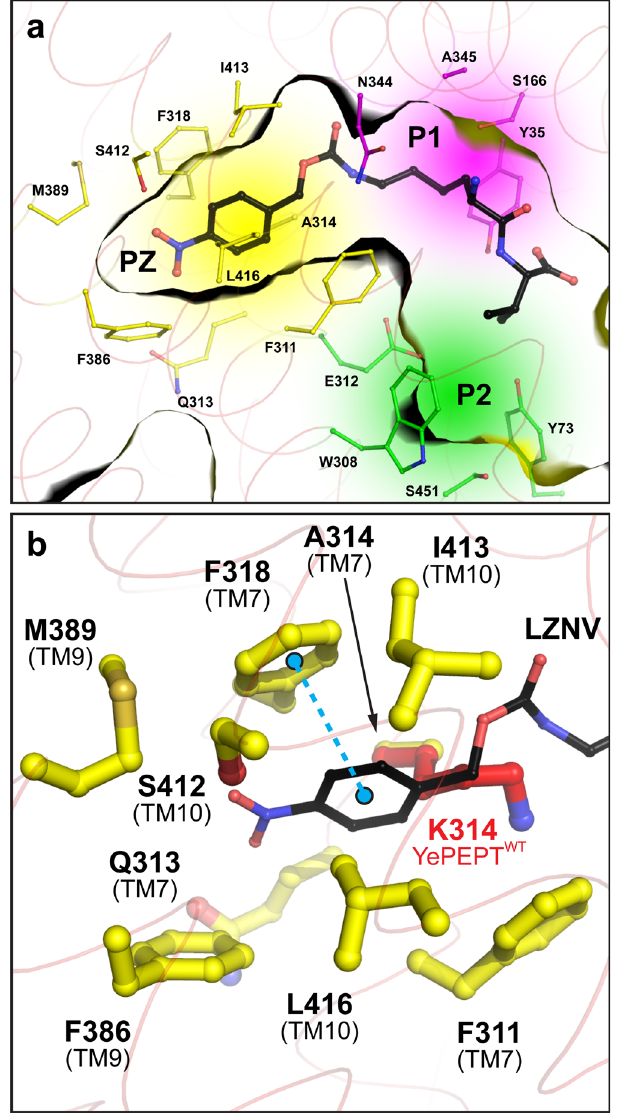
Fig. 4 LZNV binding pockets of YePEPT K314A . a Accommodation of substrate/ligand side chains in the previously described pockets P1 (purple) and P2 (green), and of the Z(NO 2 ) moiety in the newly identi fi ed pocket PZ (yellow). b Detailed view into the PZ pocket, accommodating the Z(NO 2 ) moiety of LZNV. The π -stacking interaction between F318 and the 4-nitrophenyl group of LZNV is displayed with two balls located in the centre of the aromatic rings and connected by a dashed line (cyan). The position of K314 in the structure of YePEPT WT is shown in red. Protein side chains involved in pocket formation are depicted as thin ( a ) or thicker ( b ) sticks and colour-coded according to corresponding pocket colour. Amino acids are labelled in the one-letter code and corresponding TMs are indicated in brackets. each independently mutated to alanine, ligand-dependent protein stabilisation was abolished for all resulting double mutants (i.e.,